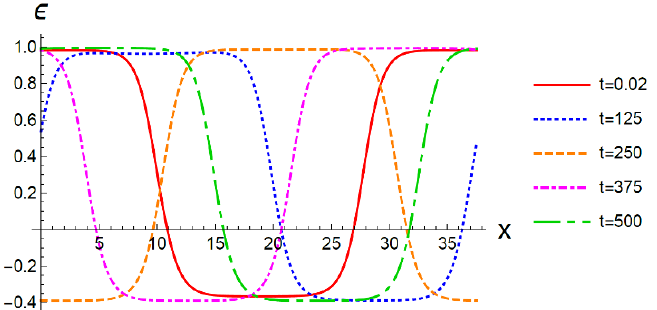
Figure 8 . Evolution of the energy density pro(cid:12)le for the initial state obtained from the (cid:12)nal snapshot in (cid:12)gure 7, modi(cid:12)ed by adding a constant C = 0 : 05 to the function ~ B ( z; x